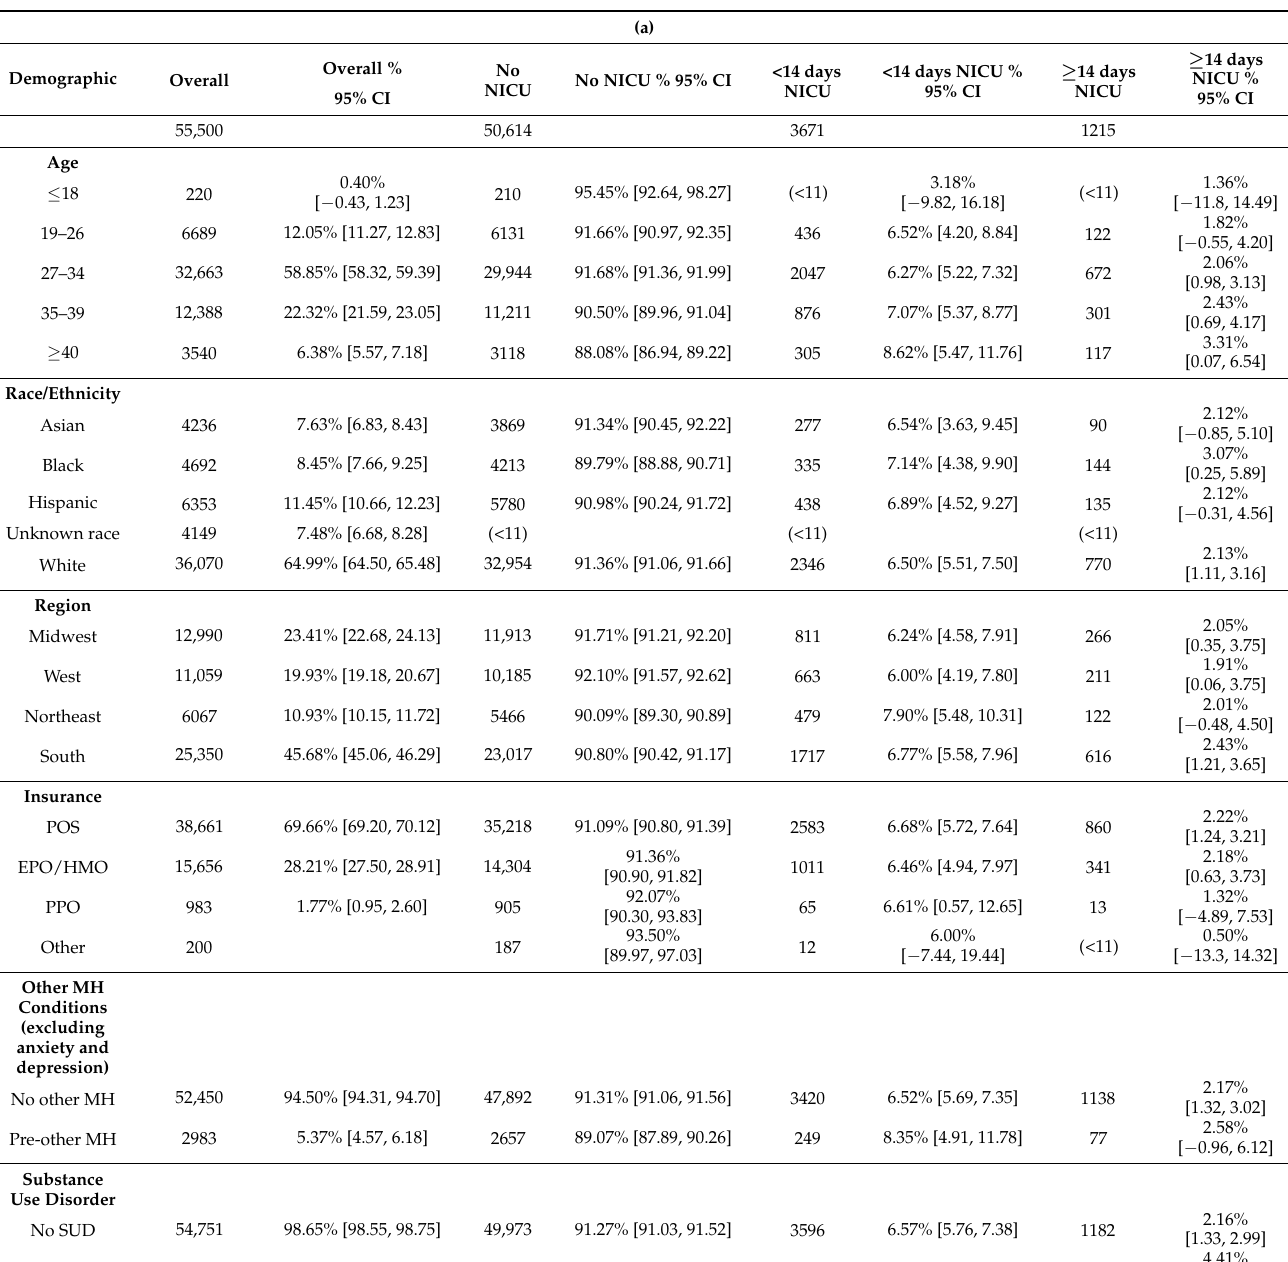
Table 1. ( a ) Cohort characteristics, in 2010, overall and by NICU status. ( b ) Cohort characteristics, in 2018, overall and by NICU